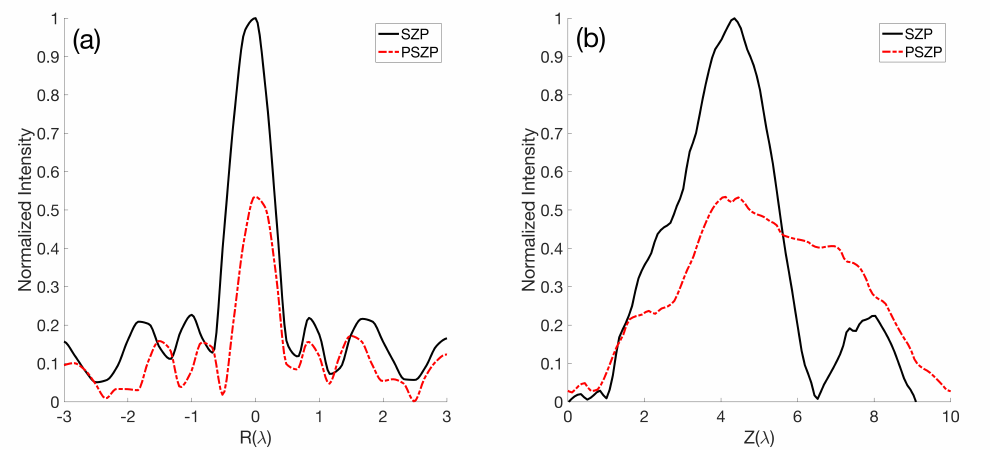
Figure 6. Experimental normalized intensity results for both implemented lenses. The axial and longitudinal axis are shown, where ( a ) corresponds to the R -axis cuts and ( b ) corresponds to the Z -axis cuts at the F L position